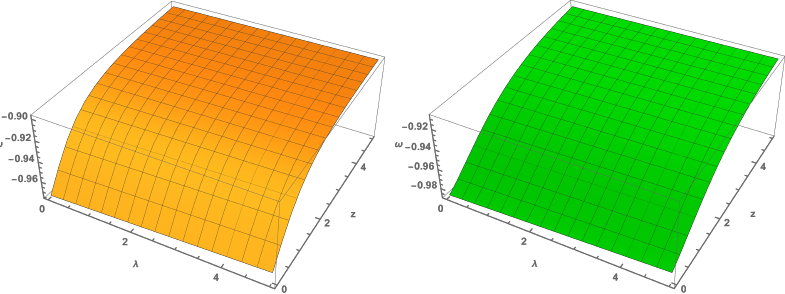
Figure 8. The behavior of EoS parameter against the redshift parameter z and λ with the constraint values of the coefficients in (29) and m = − 5, n = 1.05 for f ( Q ) = Q + mQ n . Left side graph for Hubble data and right side graph for Pantheon